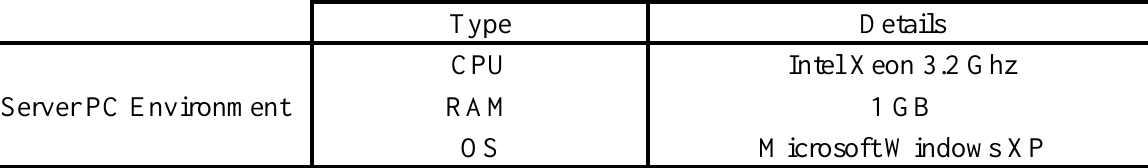
Table 1. Hardware Environment.